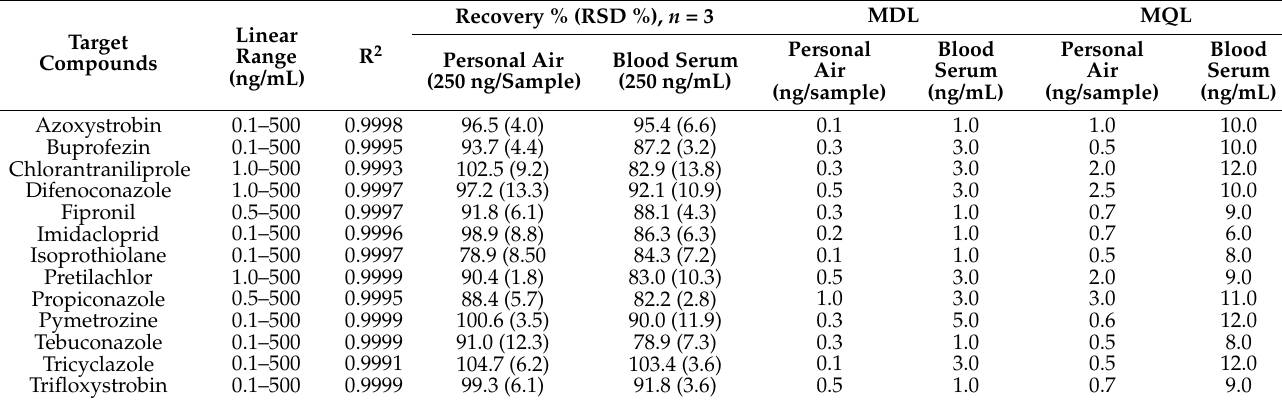
Table 1. Information on UHPLC-MS/MS and method